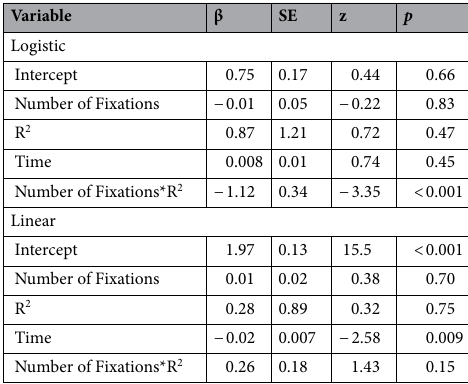
Table 2. Association between confidence and number of fixations via Two-Part Multilevel Model. Statistical outcomes for two-part multilevel models are reported separately for linear and logistic portions of the